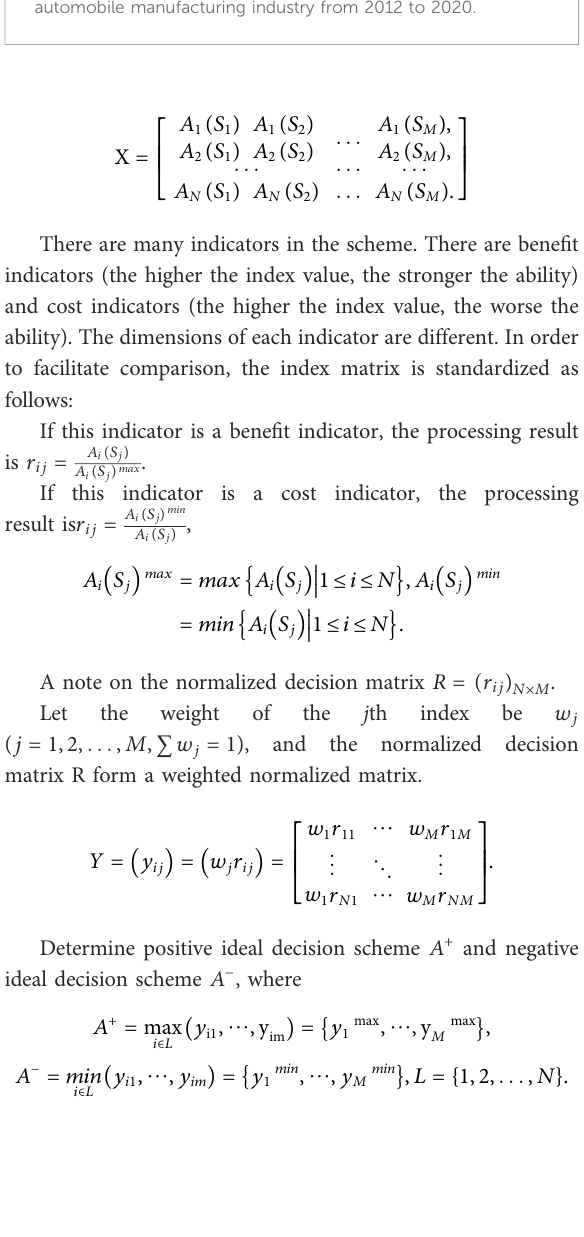
FIGURE 1 ChangesinthetotalmarketvalueofkeyenterprisesinChina ’ s automobile manufacturing industry from 2012 to